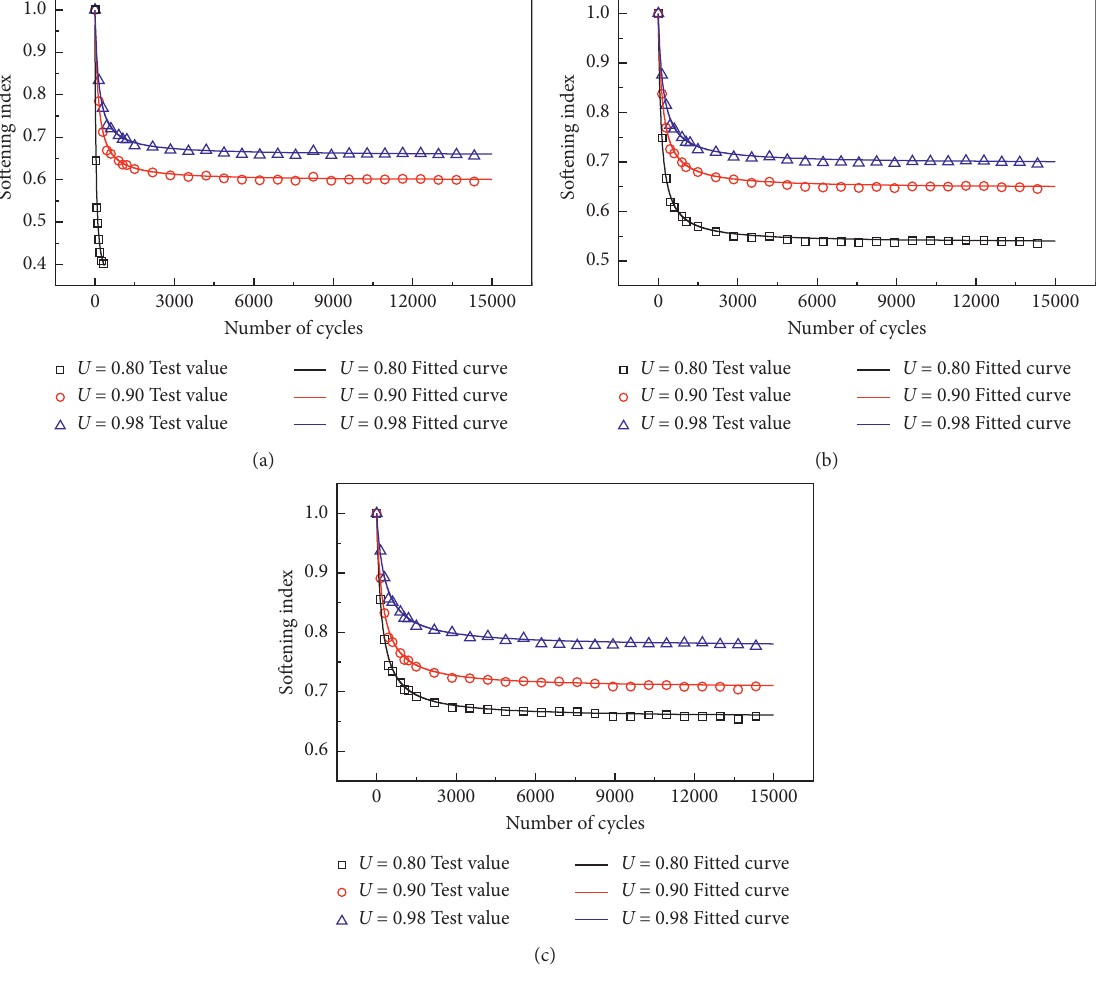
′ � 200kPa; (c) P � 20% and σ 3